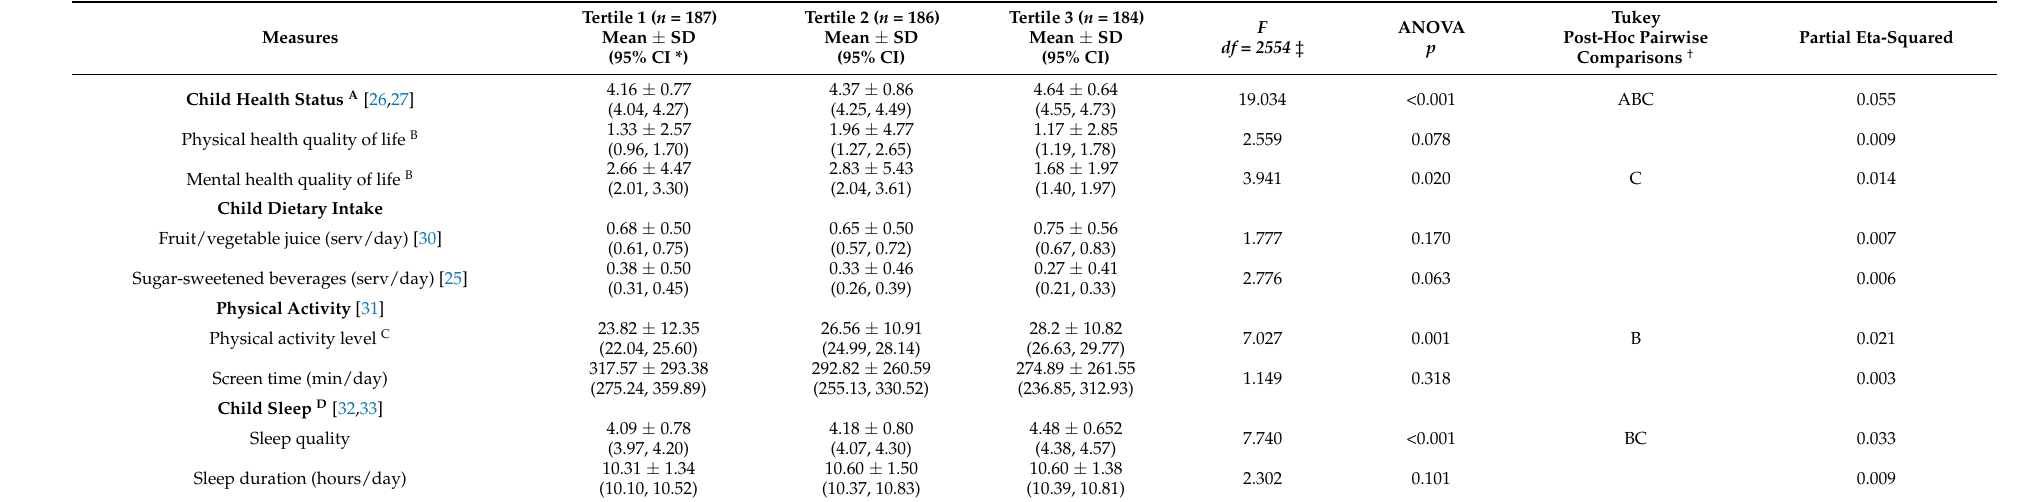
Table 4. Child health and weight-related behaviors comparisons by family social capital tertiles ( n =